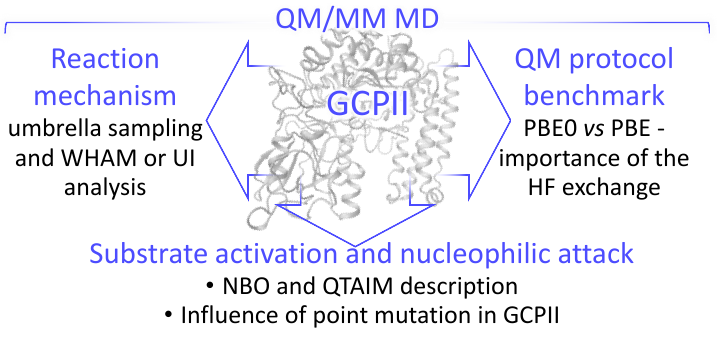
Figure 2. The framework diagram to illustrate this study.